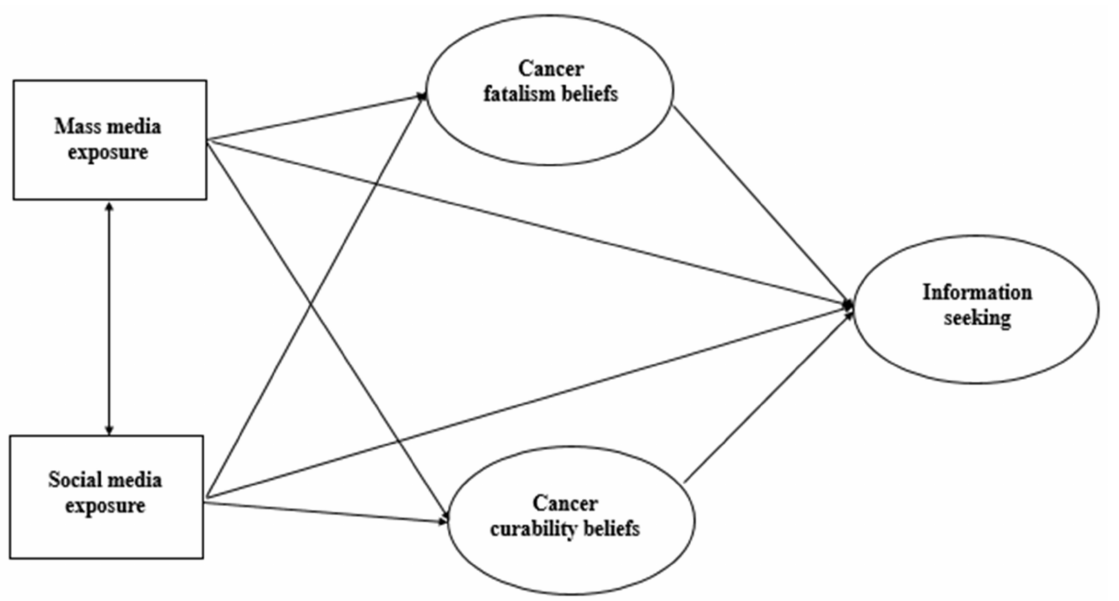
Figure 2. Structural model for cancer information seeking (Model